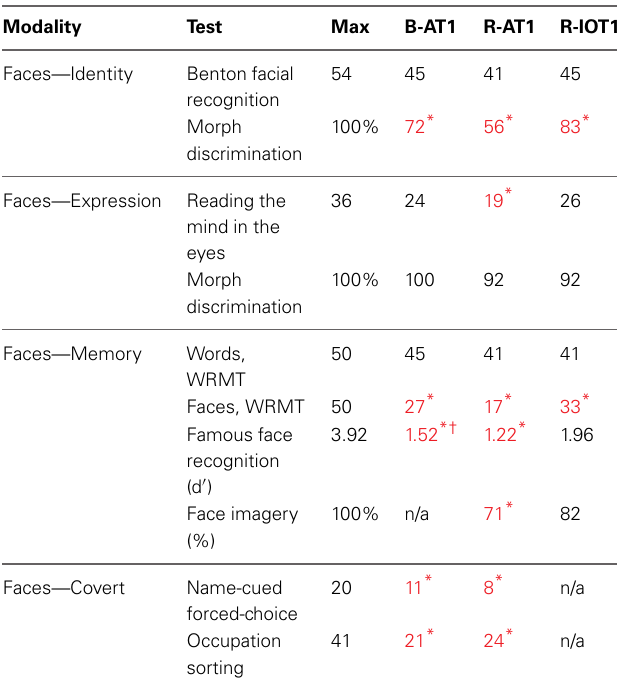
Table 1 | Results from the battery of face tests.